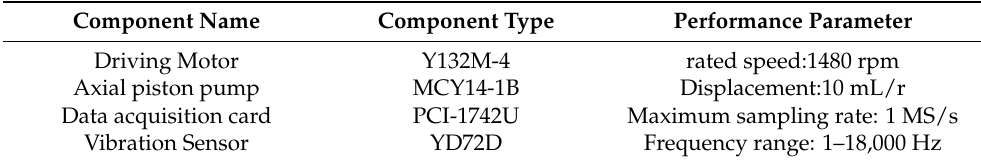
Table 10. Component models and performance parameters.